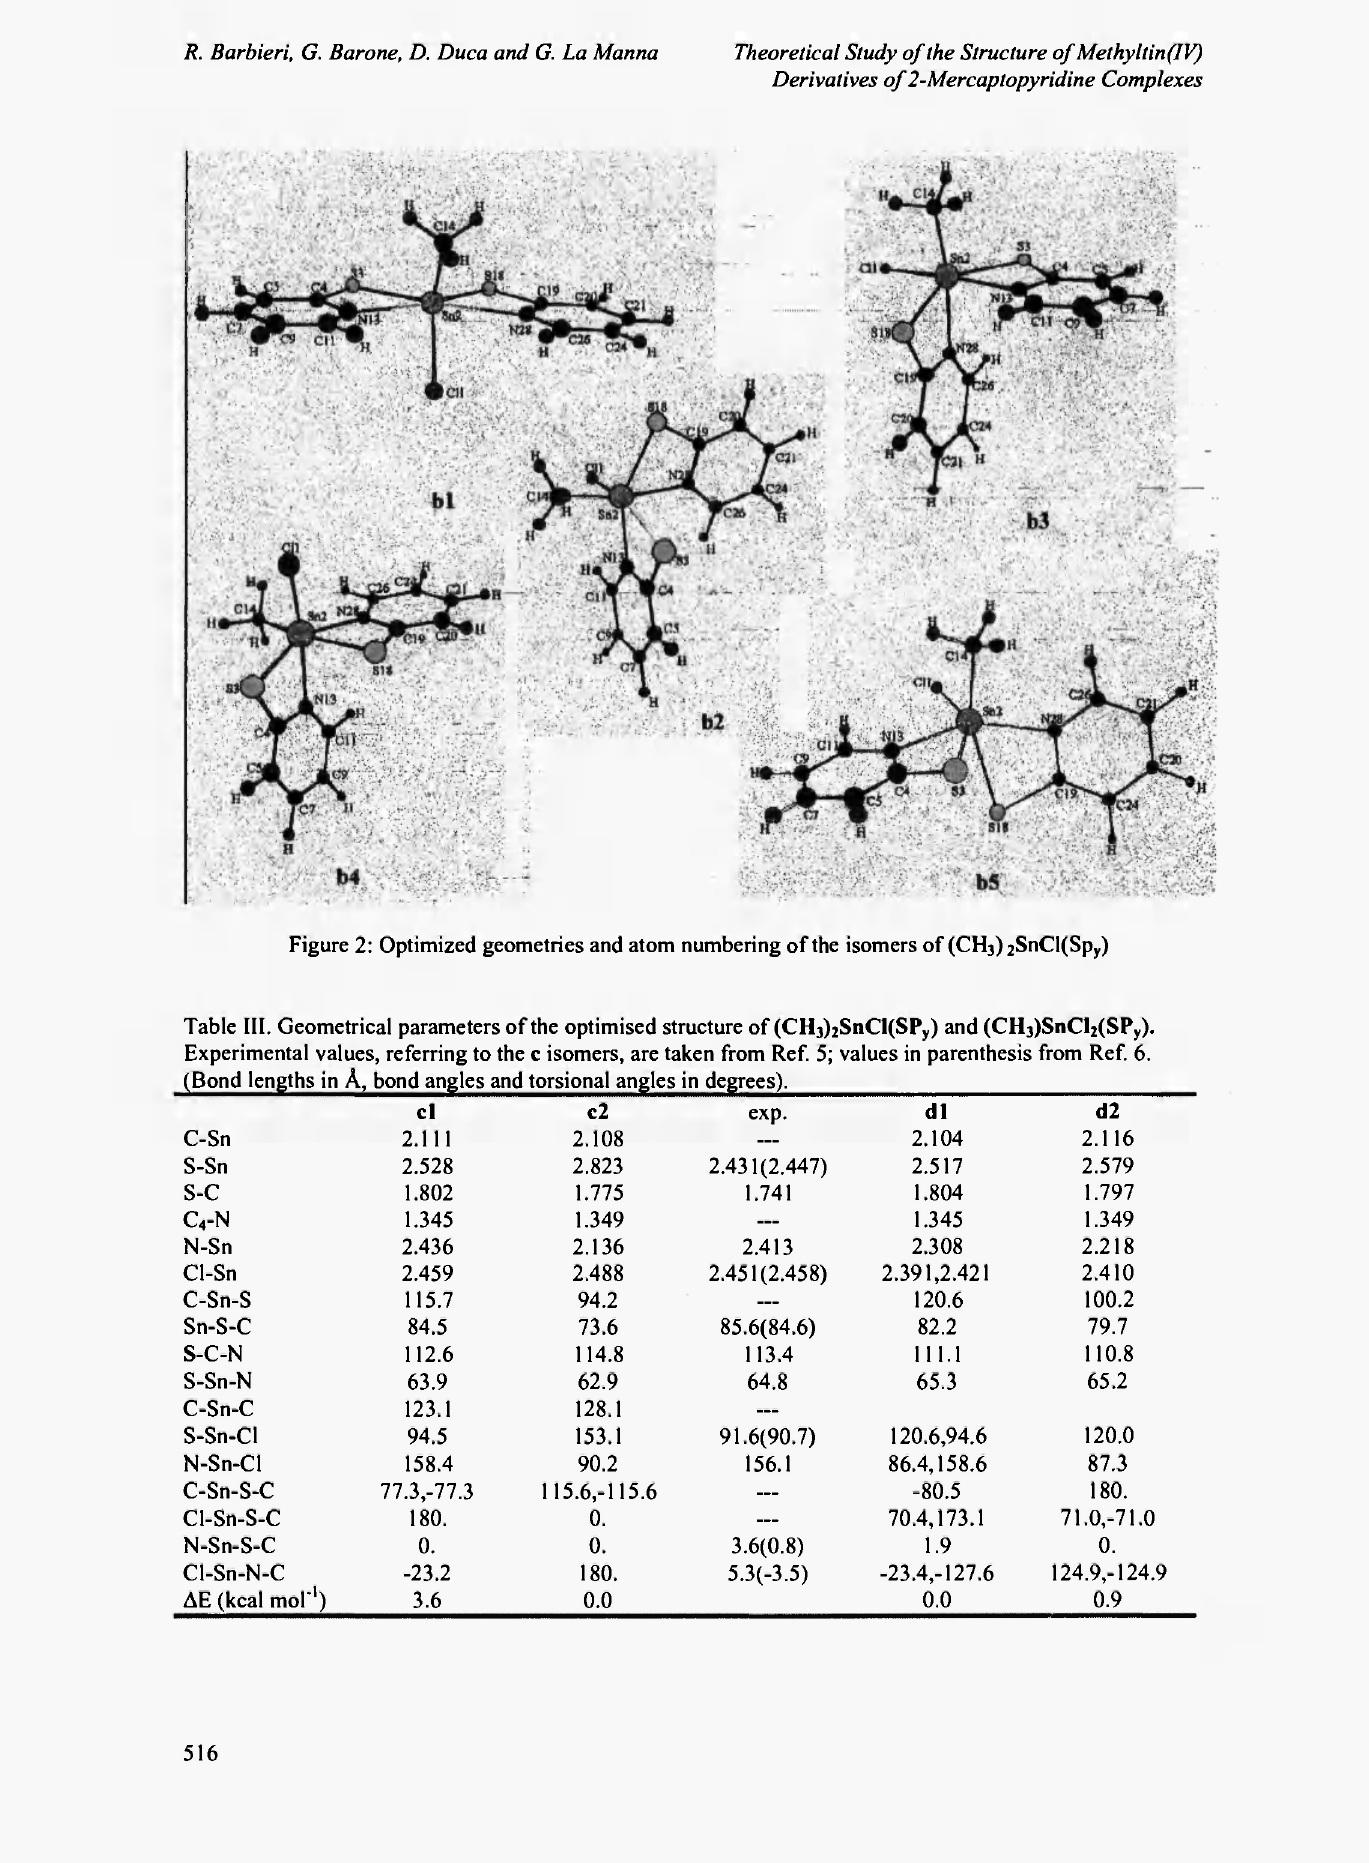
Table III. Geometrical parameters of the optimised structure of (CH3)2SnCl (SP y ) and (CH 3 )SnCl2(SP y ). Experimental values, referring to the c isomers, are taken from Ref. 5; values in parenthesis from Ref. 6. (Bond lengths in A, bond angles and torsional angles in